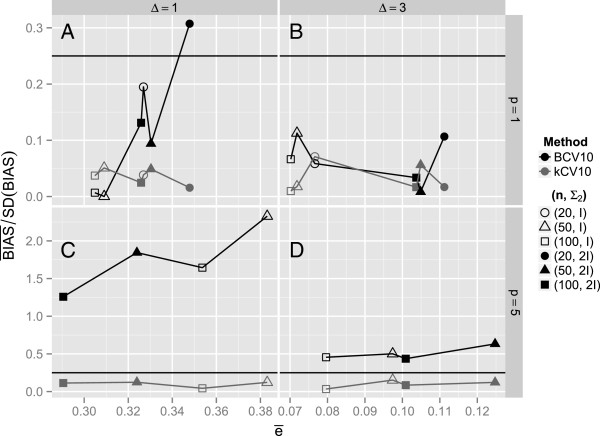
The mean relative bias expressed asBIAS―/SDBIASfor each of the twenty simulation configurations in Tables2
and3
and inAdditional file1: Table S1, Additional file2: Table S2, Additional file3: Table S3 and Additional file4: Table S4
.